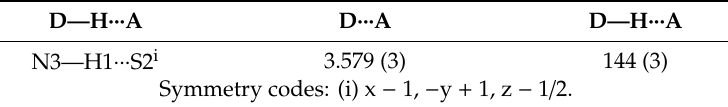
Figure 2. Molecular packing of thiazoline 5c viewed hydrogen bonds, which are drawn as dashed lines along a axis. Table 3. Hydrogen-bond geometry (Å) of thiazoline 5c Table 1. The crystal and experimental data of thiazoline 5c .